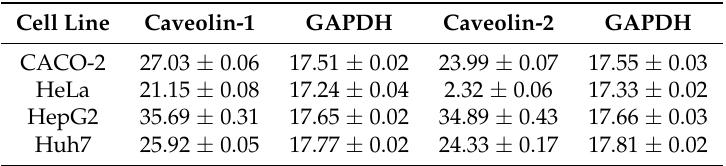
Figure 12. Caveolin1 and caveolin2 expression values compared with the control gene (glyceraldehyde-3-phosphatedehydrogenase (GAPDH)) in CACO-2, HeLa, HepG2, and Huh7 ( n = 3 experiments). Table 1. Gene expression given as the number of quantitative pCR (qPCR) cycles required to reach a threshold level, C T . The values reported are the mean and standard deviation obtained from n = 3 experiments. ∆ CT values derived from this data are plotted in Figure 12.